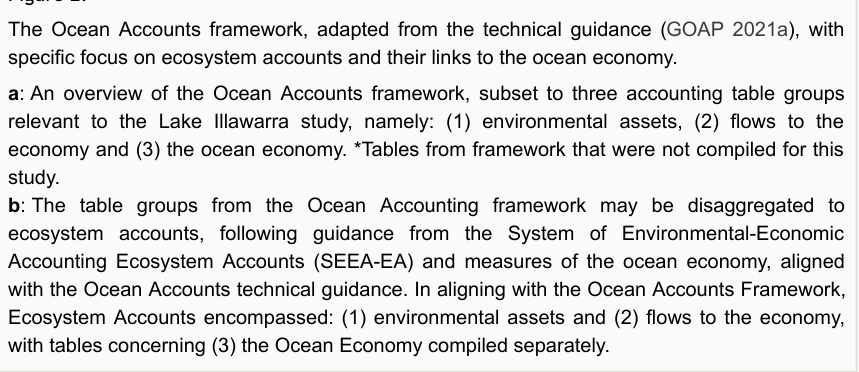
b : The table groups from the Ocean Accounting framework may be disaggregated to ecosystem accounts, following guidance from the System of